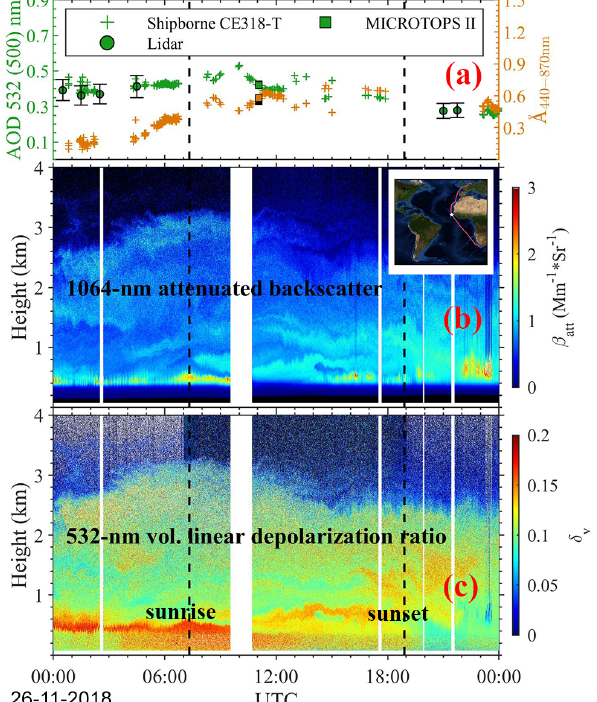
Figure 6. Shipborne aerosol observation with CE318-T, MICRO- TOPS II and Polly XT lidar at conditions with a mixture of dust and smoke on 26 November 2018. (a) Comparison of 532nm AOD from shipborne CE318-T and Polly XT lidar observations and 500nm AOD from MICROTOPS II measurements and Ångström expo- nent at 440–870nm obtained from shipborne CE318-T and MI- CROTOPS II data, (b) mixed layer extended to about 3.5km height as observed with lidar in terms of 1064nm attenuated backscatter and (c) volume depolarization ratio indicating a dust-contaminated MBL. The narrow vertical white stripes are the lidar depolarization calibration periods and the thick white vertical stripe at 10:00UTC is the routine turn-off time to avoid solar damage at noon.